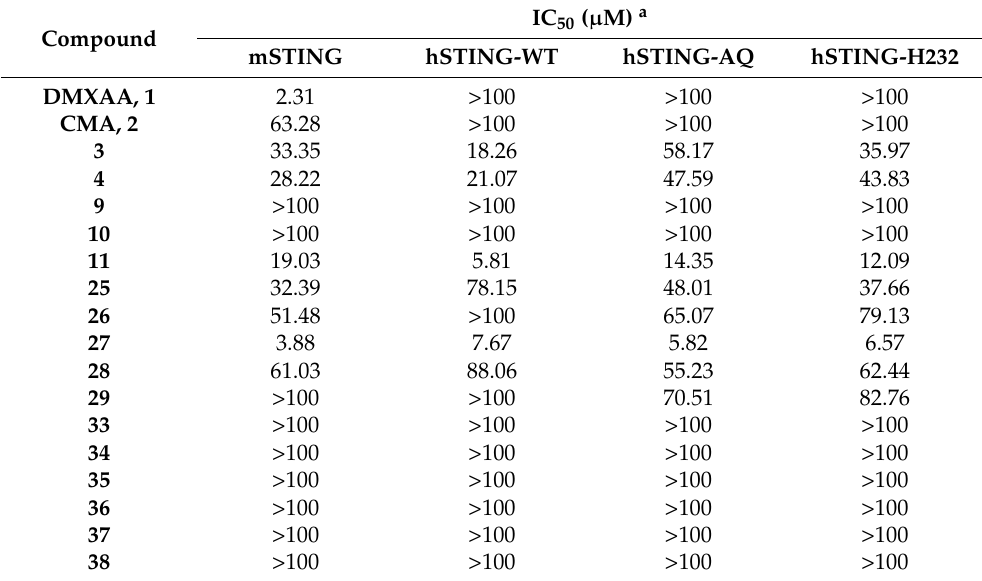
Table 2. The results of compounds with various hSTING isoforms and mSTING competition bind- ing